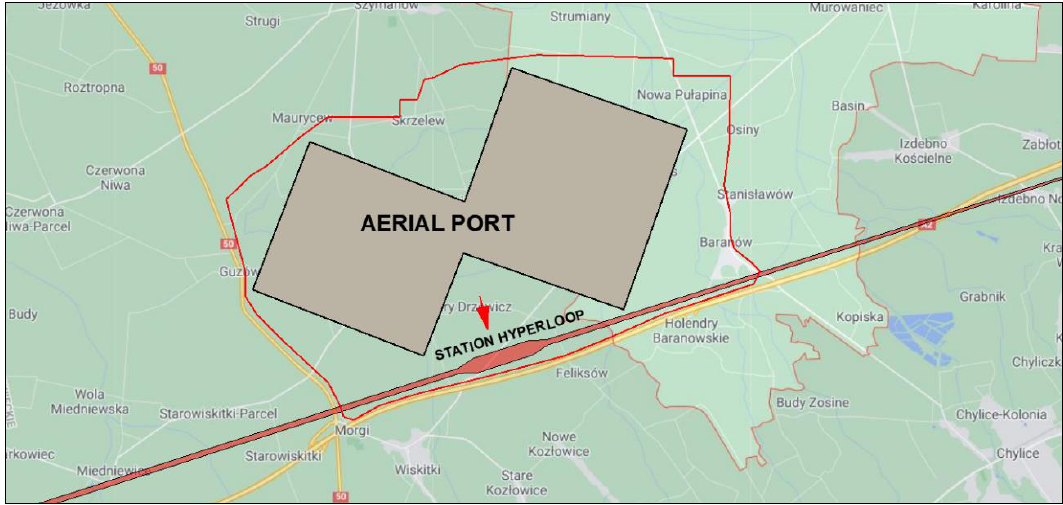
Figure 3. Potential location of Hyperloop station at the STH. Adaptation of [94].